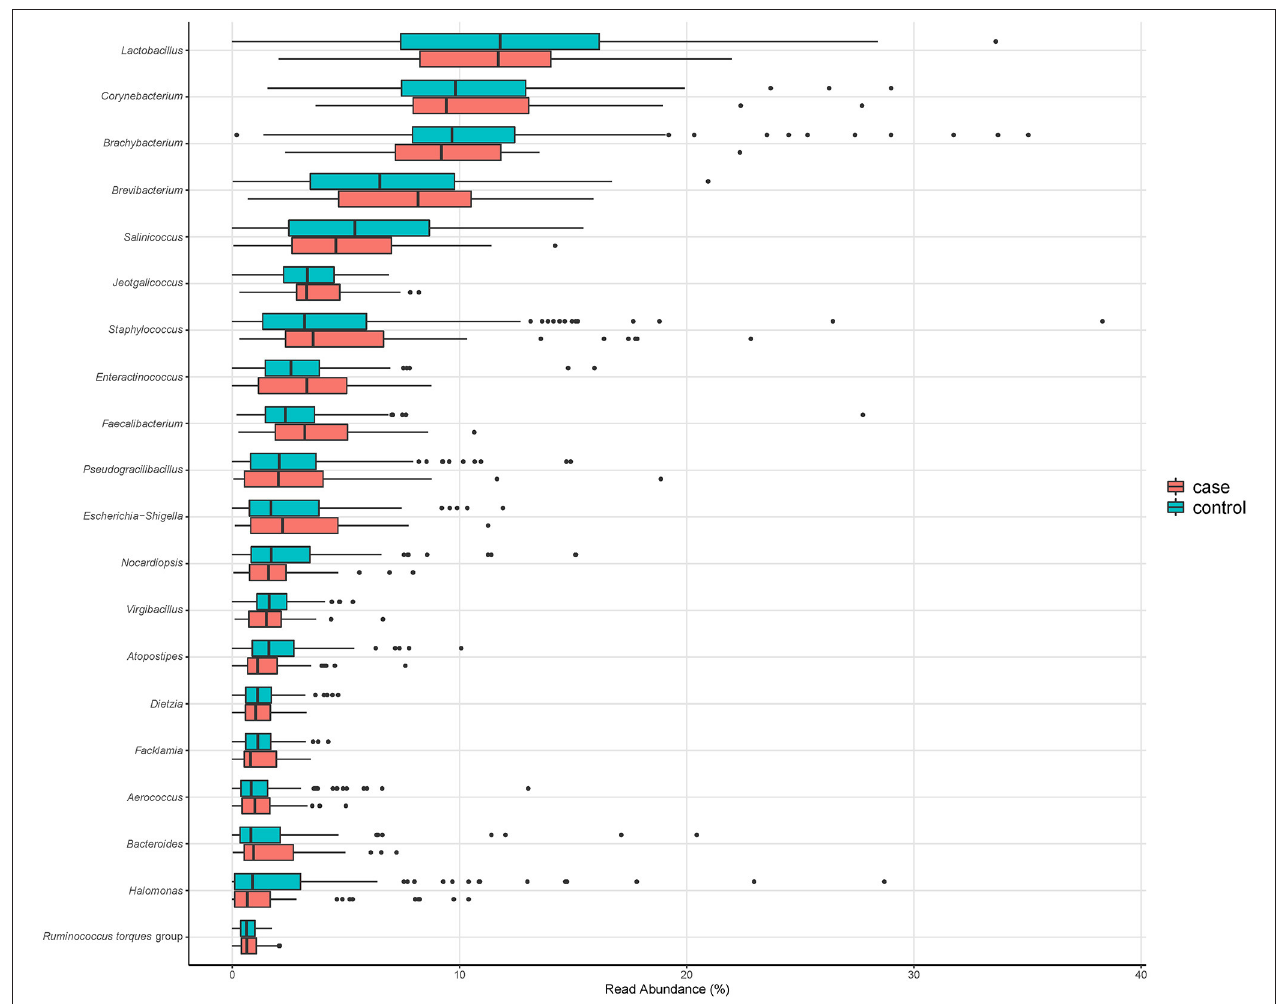
FIGURE 1 | Relative abundance of the 20 most abundant genera in composite broiler litter samples. Samples are separated by the Campylobacter isolation status of the flock. Flocks were classified as cases when either C. jejuni or C. coli was isolated in boot sock samples, or as controls